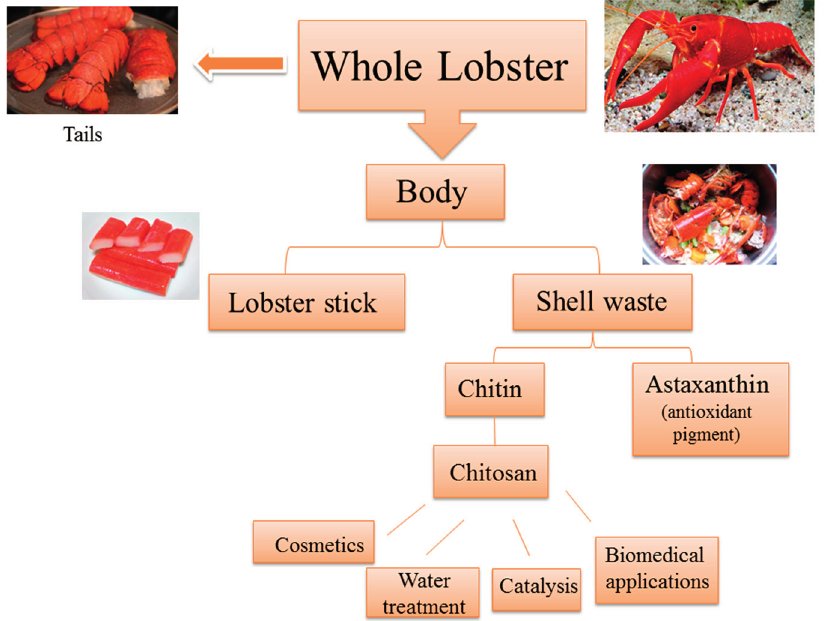
Figure 1. The lobster